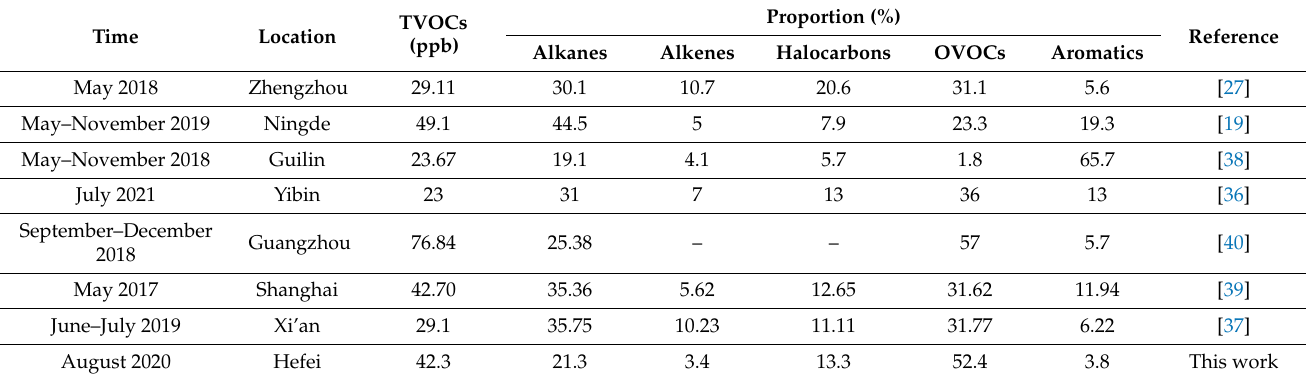
Table 1. Mixing ratio and proportion of VOC components in Hefei and other cities in China.